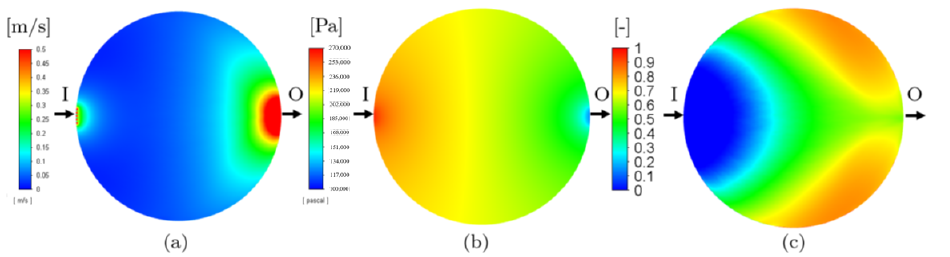
Figure 10. Distribution of ( a ) velocity; ( b ) pressure; and ( c ) oxygen volume fraction of the porous volume model.